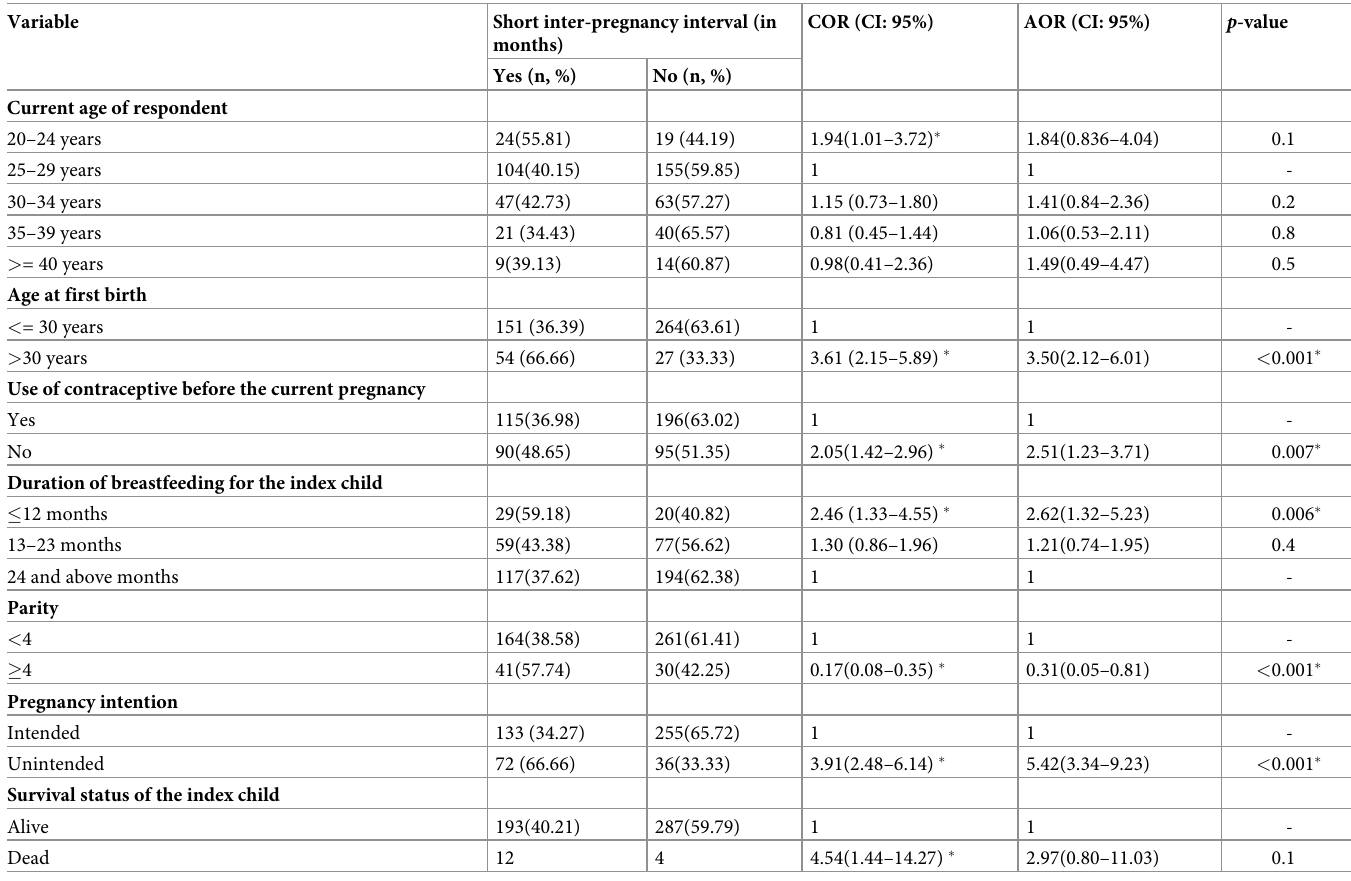
Table 3. Bivariable and multivariable binary logistic regression analyses results of factors associated with short inter pregnancy interval among pregnant women in Debre Berhan town, Amahra region, Ethiopia, 2020.